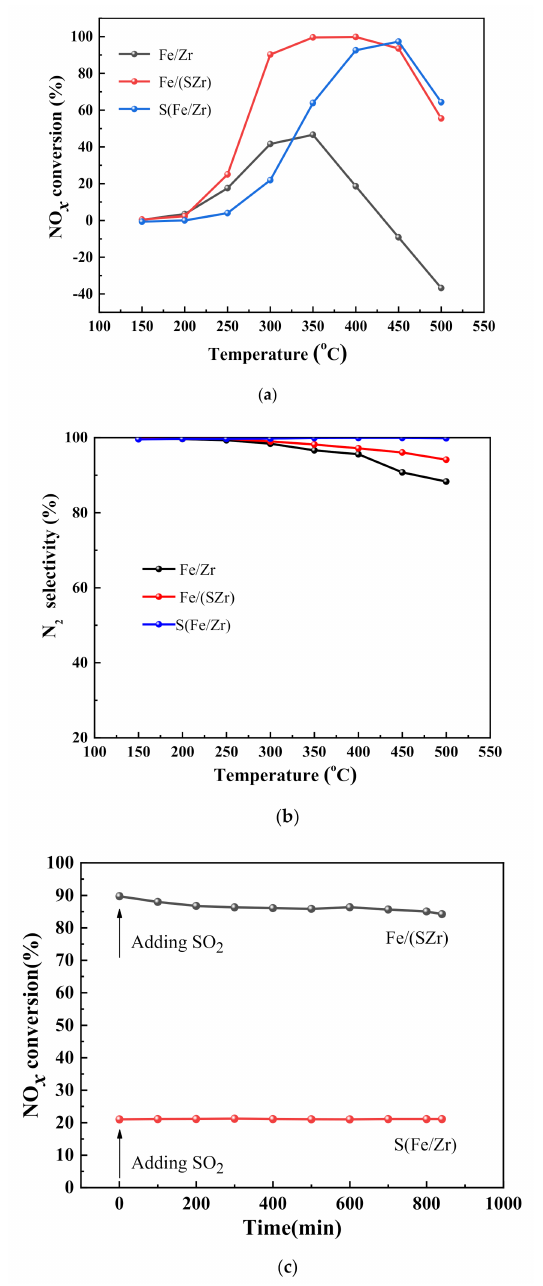
Figure 1. ( a )NH 3 –selective catalytic reduction (SCR) activity, ( b ) N 2 selectivity, and ( c ) influence of SO 2 on NO x conversion of Fe / Zr, Fe / (SZr), and S(Fe / Zr) for the NO x reduction with NH 3